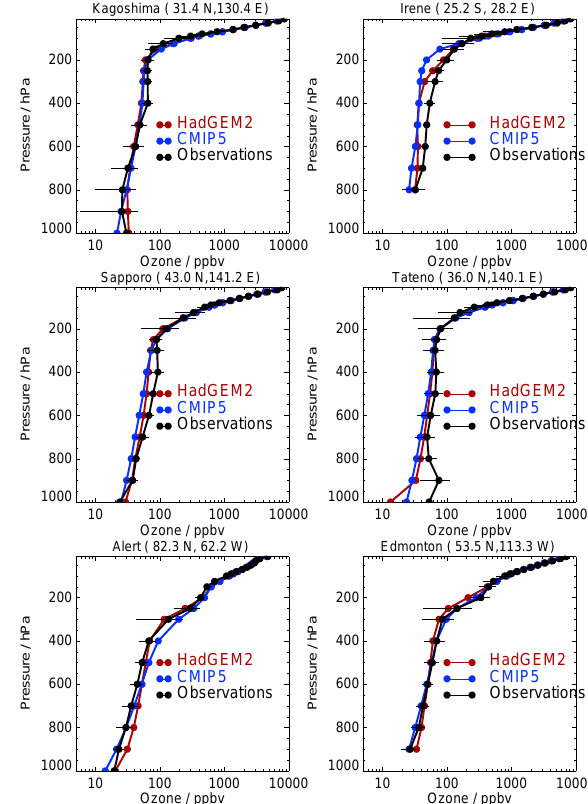
Fig. 11. Differences in dust load (above) and bare soil fraction (below) between HadGEM2-ES and an atmosphere-only simulation (HadGEM2-A) forced by AMIP SSTs, using fixed vegetation from IGBP. Values are decadal means 1991–2000.